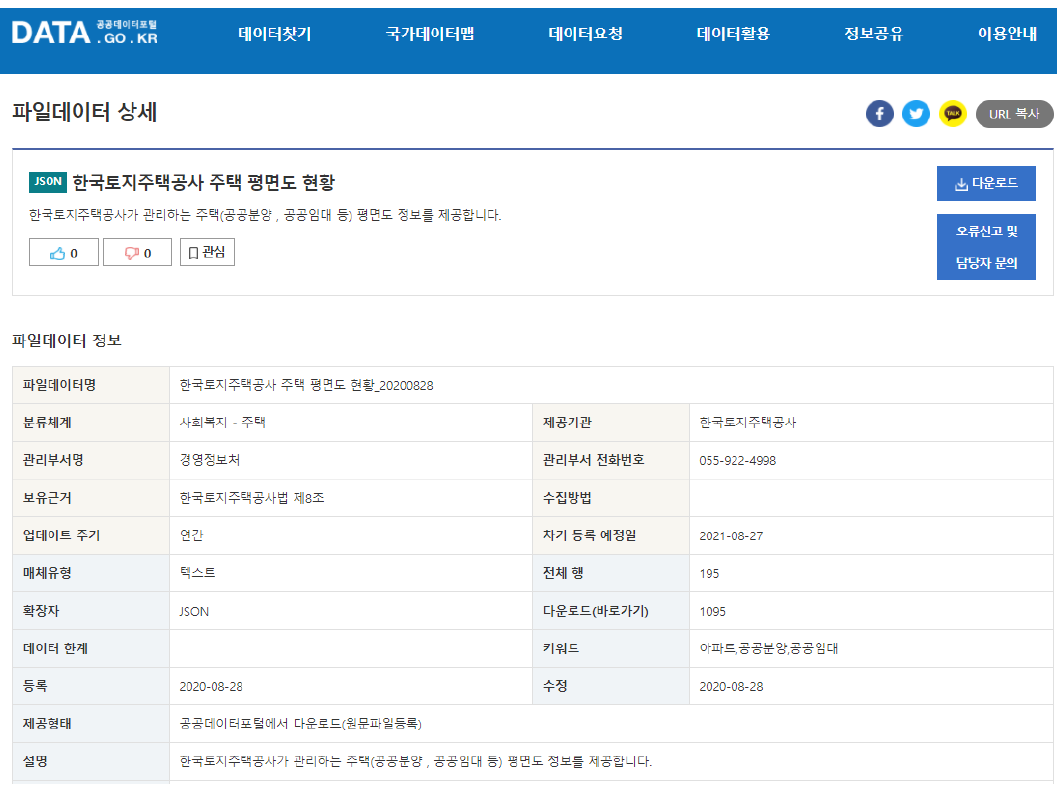
Figure 3. Korean government data portal.